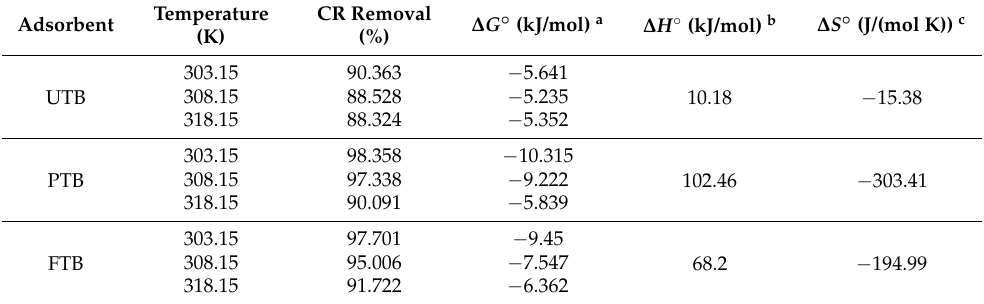
Table 4. Thermodynamic parameters of congo red (CR) adsorption by untreated sugarcane bagasse (UTB), alkali and ionic liquid pretreated sugarcane bagasse (PTB), and fermented sugarcane bagasse (FTB). Temperature CR Removal ∆ G ◦ (kJ/mol) a ∆ H ◦ (kJ/mol) b ∆ S ◦ (J/(mol K)) c Adsorbent (K) (%) UTB